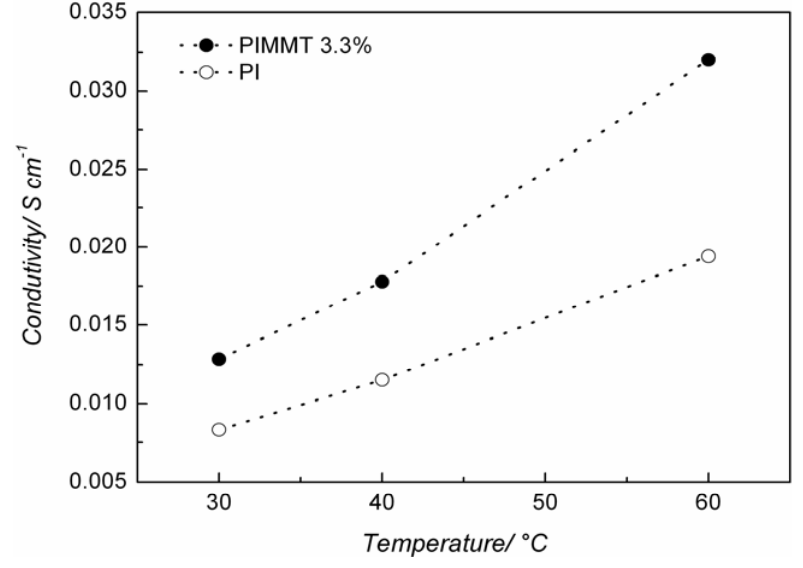
Figure 7. Conductivity for pure PI and PI/-O-MMT nanocomposite as a function of temperature.